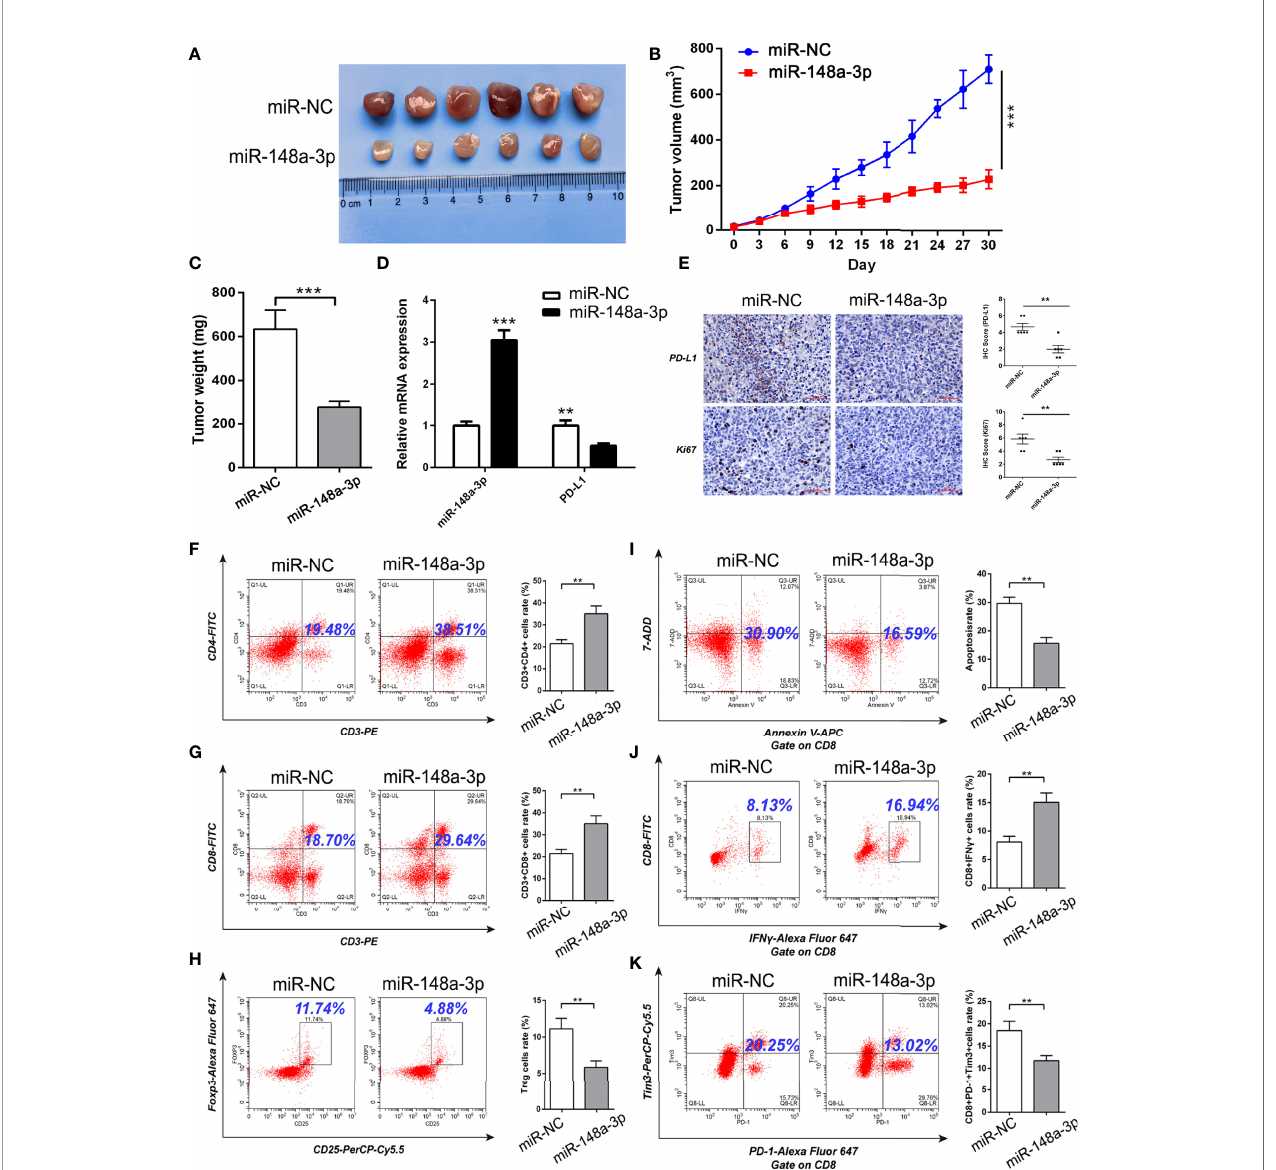
FIGURE 8 | MiR-148a-3p inhibited the formation of PC immunosuppressive microenvironment via targeting PD-L1 in murine xenograft model. (A) Representative images of xenograft tumors. (B, C) Tumor growth curves and tumor weights. (D) qRT-PCR analysis of the expression of miR-148a-3p and PD-L1 in the tumor tissues. (E) IHC staining of PD-L1 and Ki67 in the tumor tissues. (F – H) Flow cytometry analysis of the proportion of CD4 + , CD8 + T cells and Tregs in the tumor tissues. (I – K) Flow cytometry analysis of apoptosis, function and exhaustion of CD8 + T cells in the tumor tissues. Data were expressed as means ± SD of three independent experiments. ** P < 0.01, *** P <